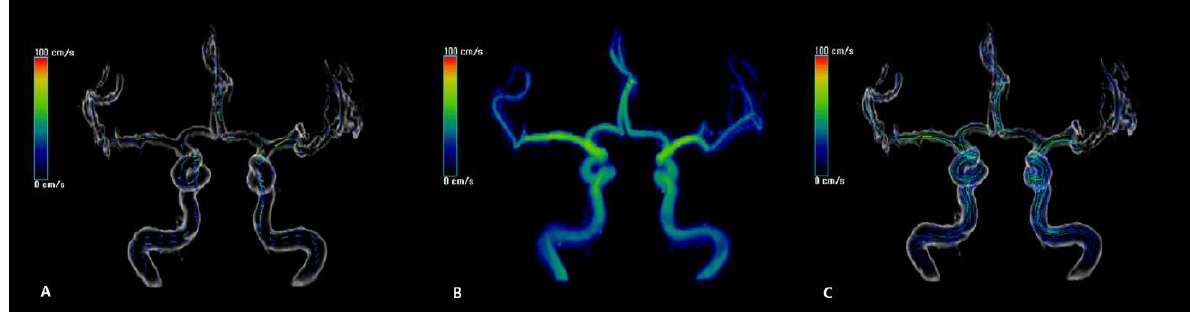
Figure 2. Static captures of four-dimensional flow MRI. Anterior circulation of a 39-year-old woman with normal intracranial arteries. ( A ) Color-coded three-dimensional (3D) rendering shows velocity vectors, which visualize the direction of blood flow; ( B ) Color-coded 3D rendering of flow velocity, which displays velocity changes according to the cardiac cycle; ( C ) Color-coded 3D rendering with streamlines, which represent the path of particles if the particles are released into the velocity field while the field is kept constant.